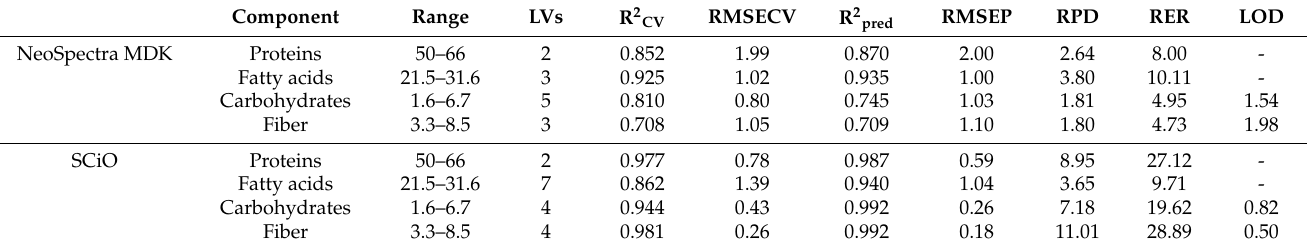
Table 2. Best prediction models obtained for the macronutrients in insect powder samples. LV = latent variables. Range, RMSECV, RMSEP, and LOD are expressed as g/100 g insect powder. The component values are as they are expressed in the commercial